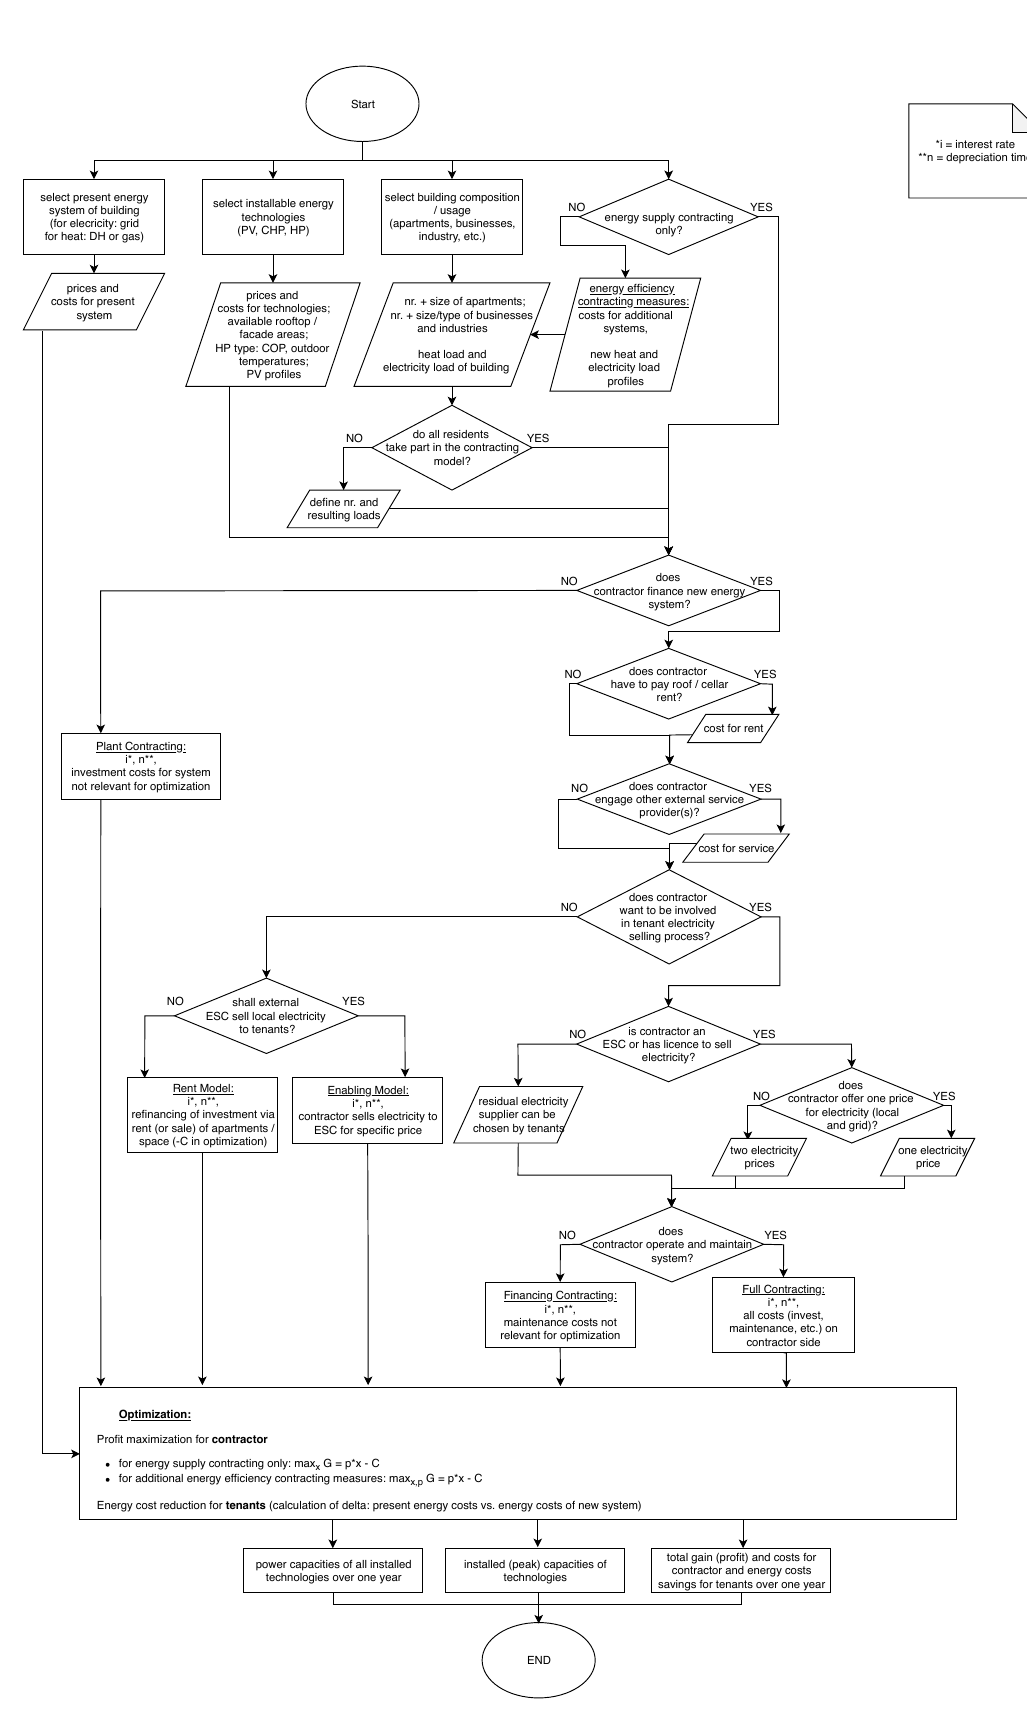
Figure 3. Flow chart of the optimization